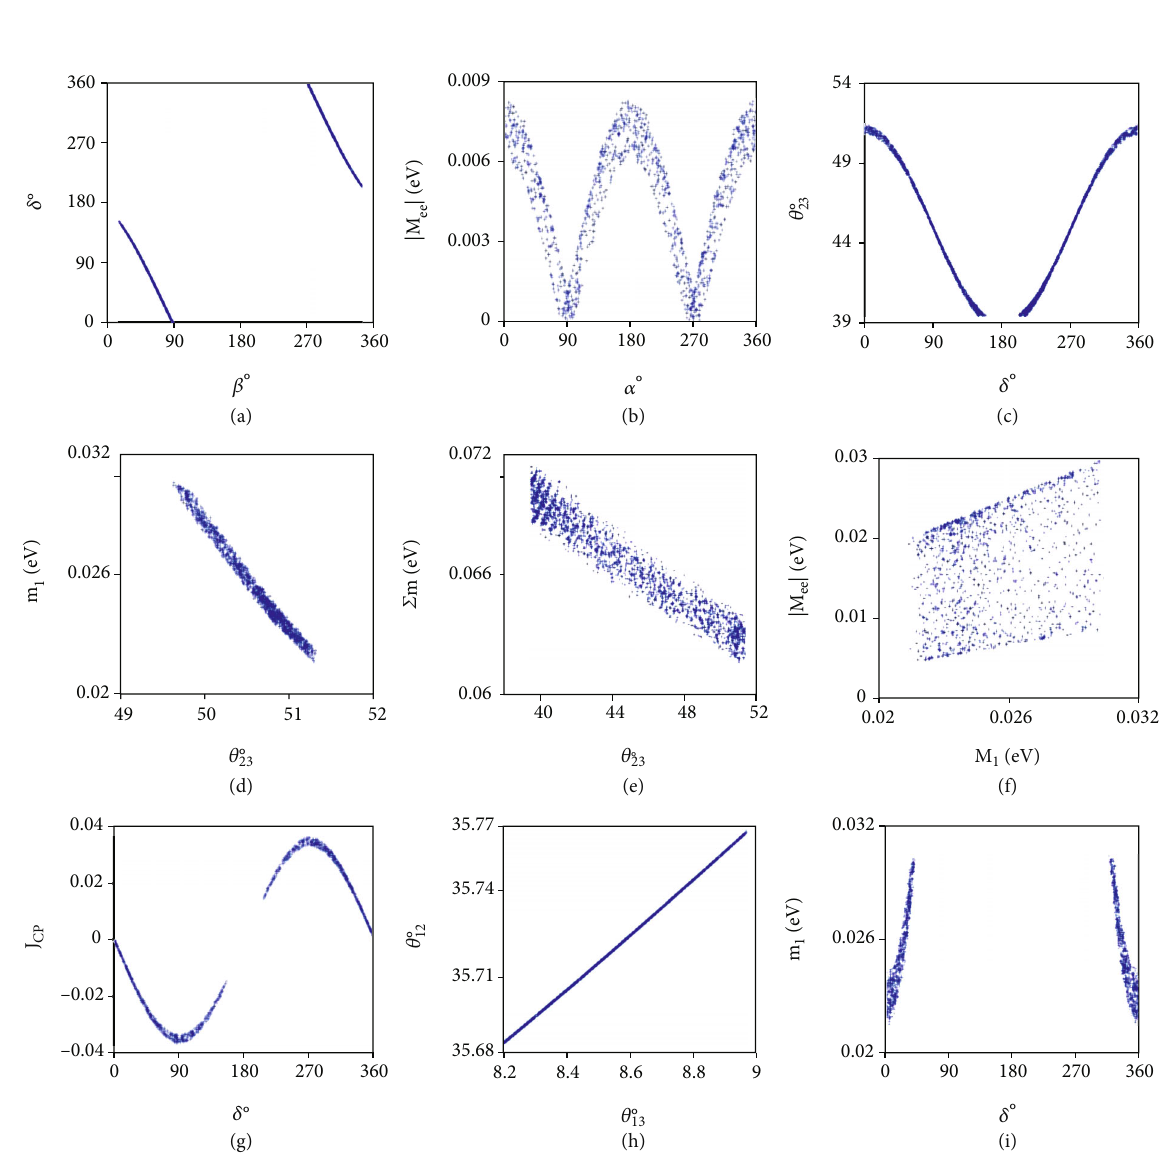
Figure 1: Correlation plots among various parameters for textures (a) M 1 (h) M 3 , and (i) M 5 TM 2